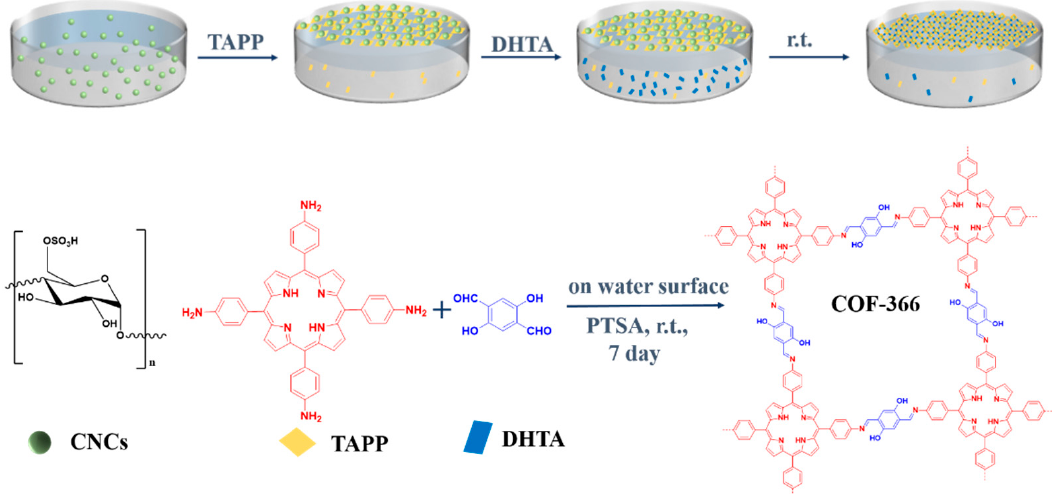
Figure 1. Synthesis process and reaction scheme of the COF-366 film at the air–water interface by using CNCs as a template.